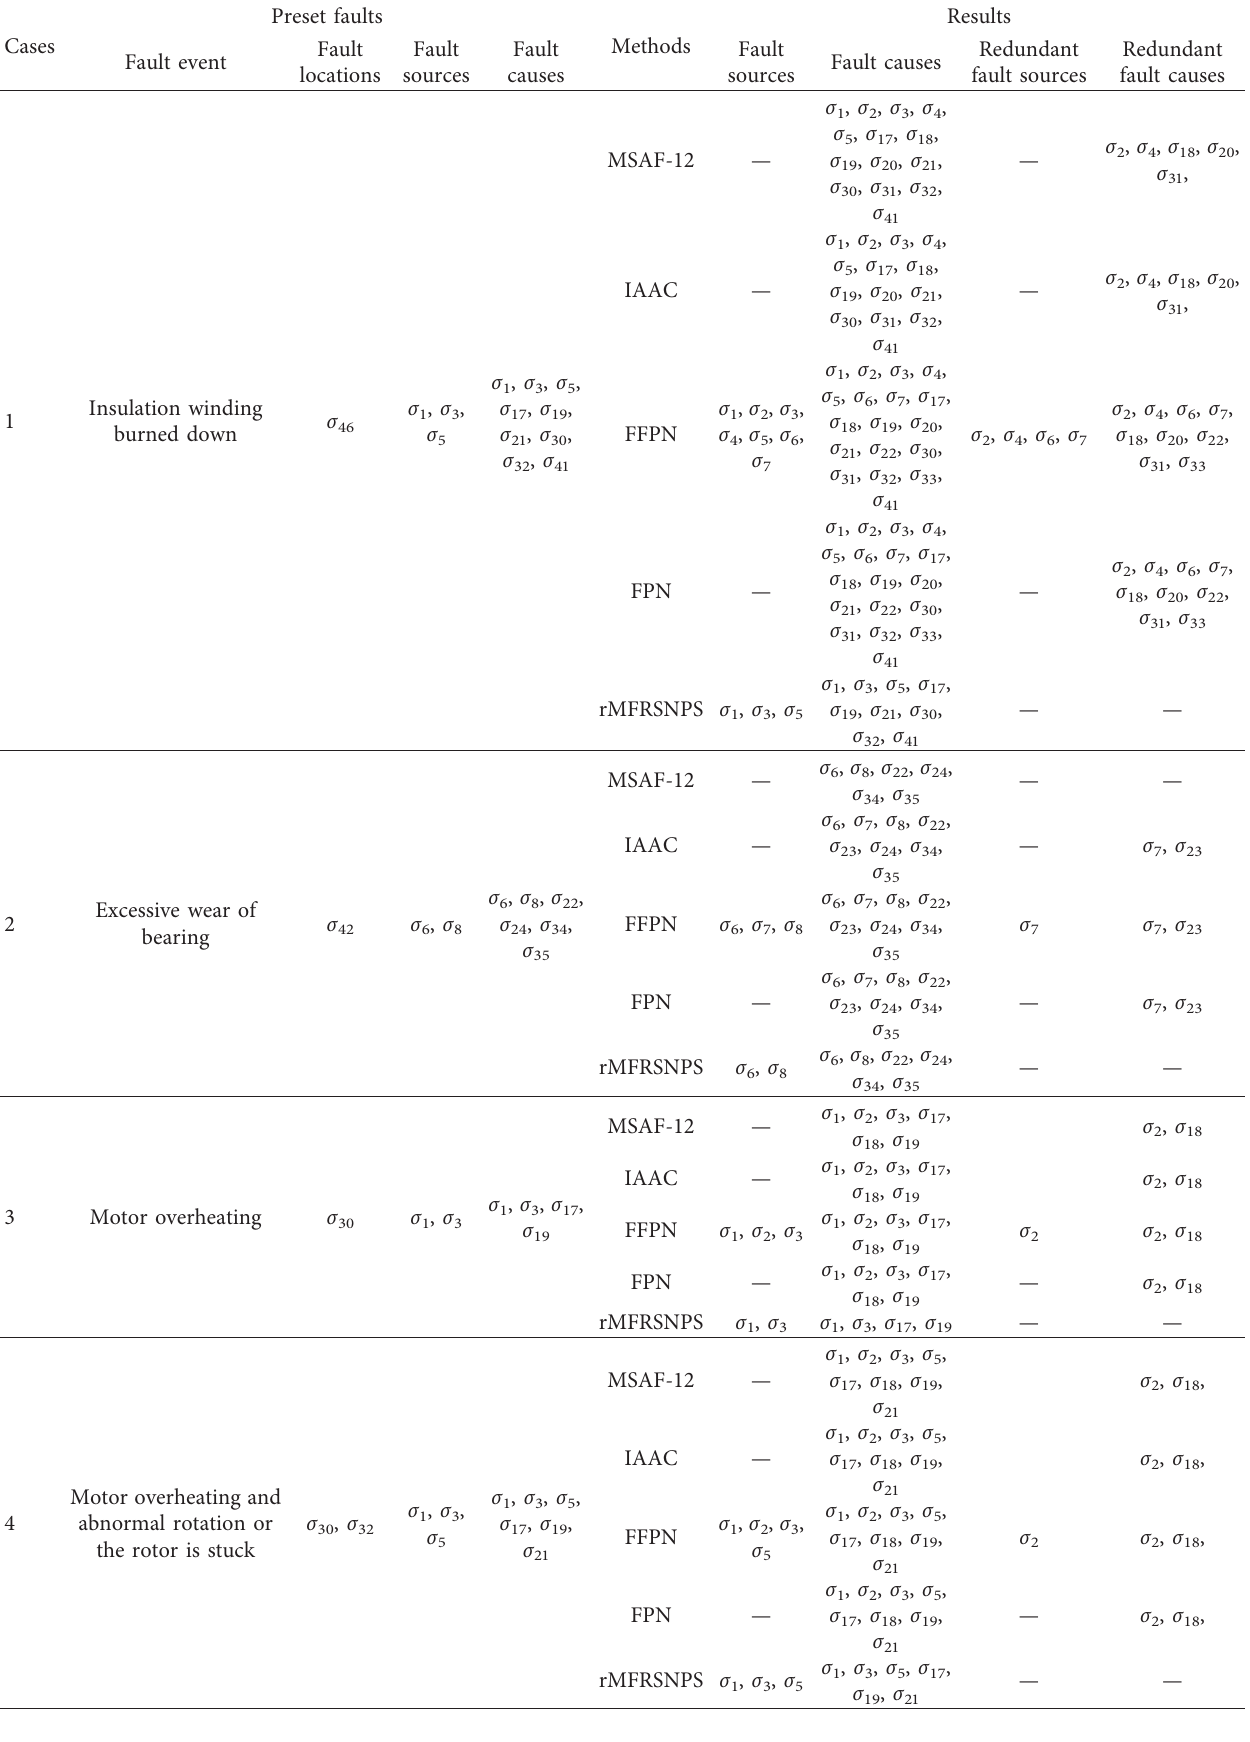
Table 2: Results comparison of the rMFRSNPS and four other